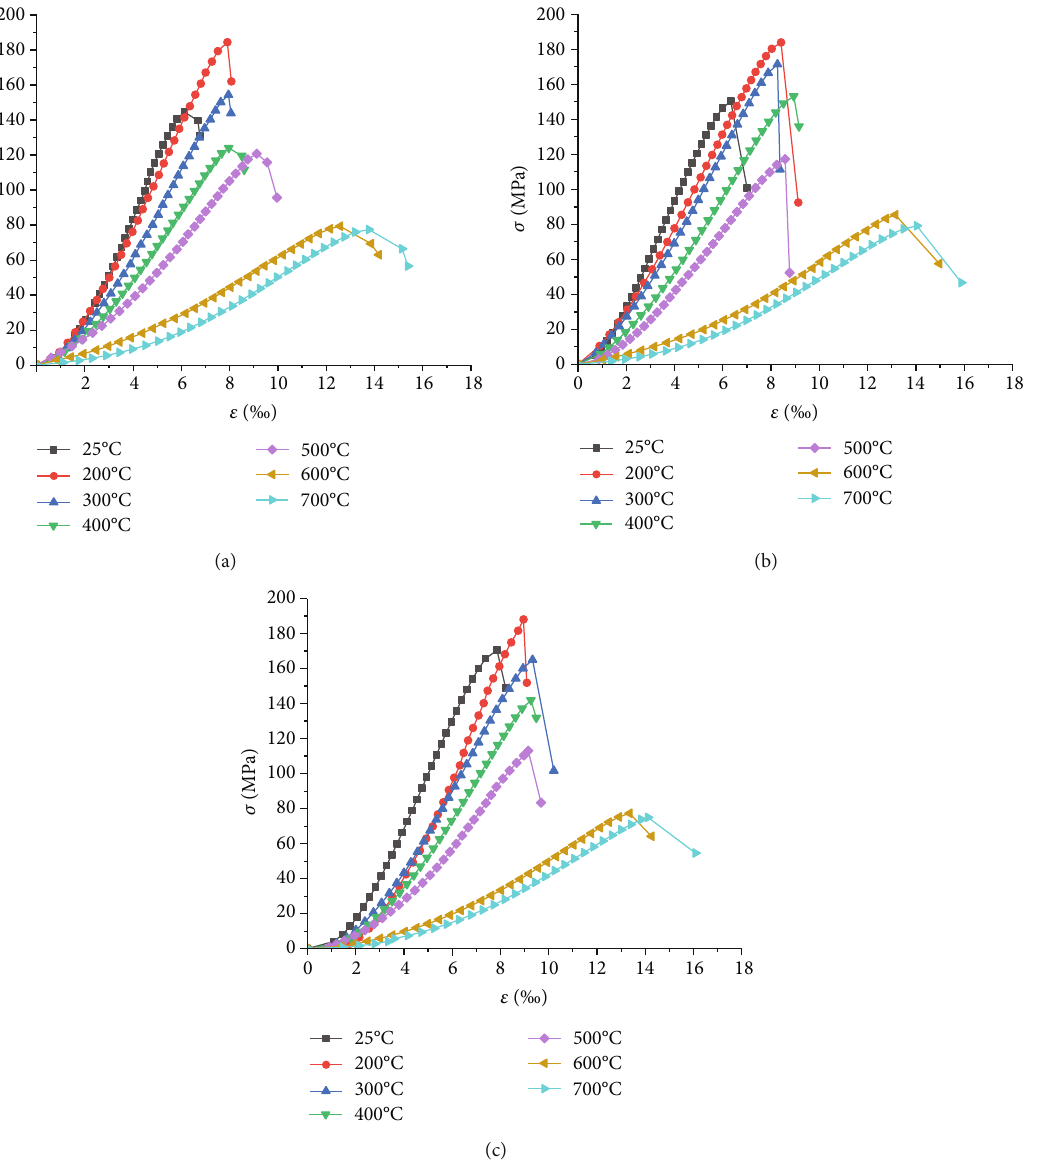
Figure 4: Stress-strain curves of granite under uniaxial compression at real-time high temperature: (a) 0.01 mm/min; (b) 0.1mm/min; (c)